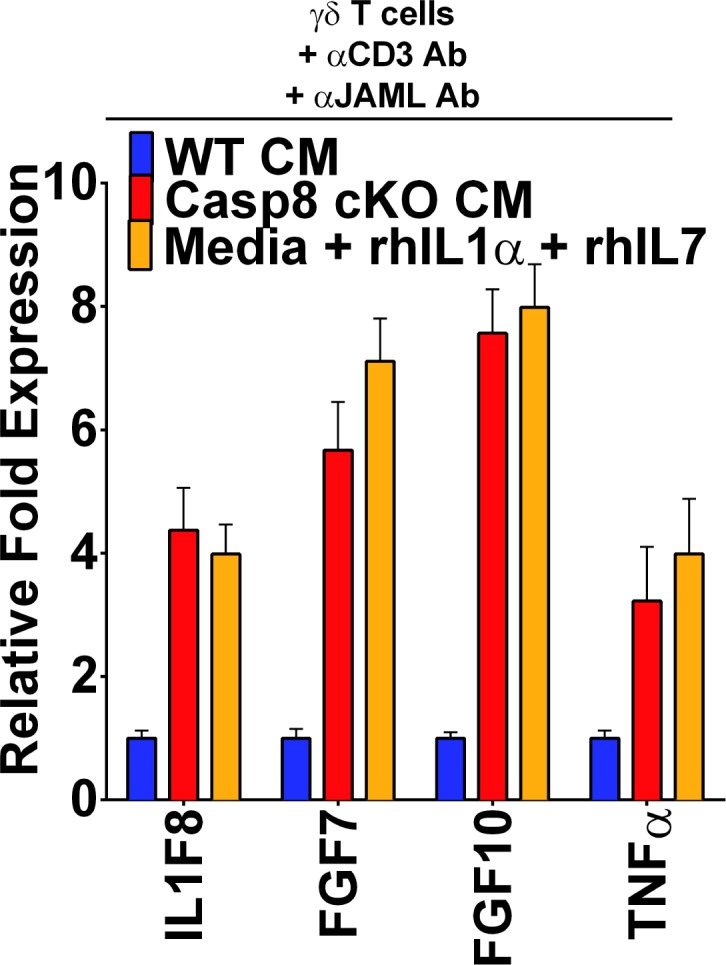
Expression of IL-1 family members by activated γδT-cells.qPCR of short-term γδT-cell cultures. The data shown are averagesfrom three independent experiments.